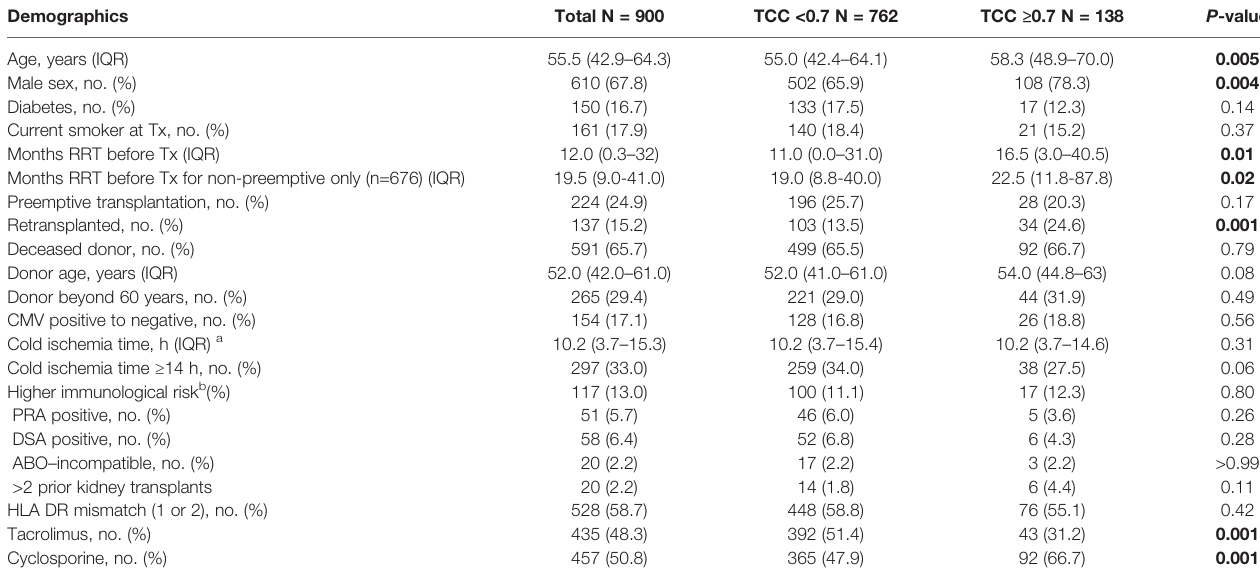
TABLE 1 | Demographics of 900 kidney transplant recipients according to TCC ≥ 0.7 CAU/ml (n = 138, 15.3%) and TCC <0.7 CAU/ml (n = 762, 84.7%).